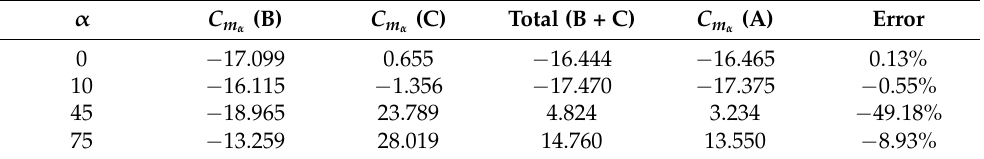
Figure 17. Comparison of 𝐶 (cid:3040) Table 4. Comparison of C m